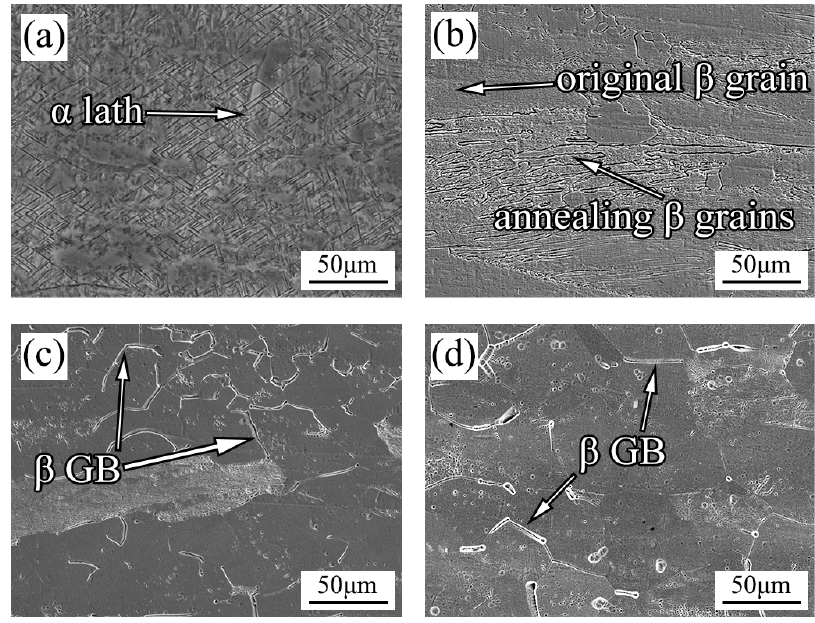
Figure 2. SEM images of annealed Ti-20Zr-15Mo alloys: ( a ) 500 ◦ C; ( b ) 600 ◦ C; ( c ) 700 ◦ C; ( d ) 800 ◦